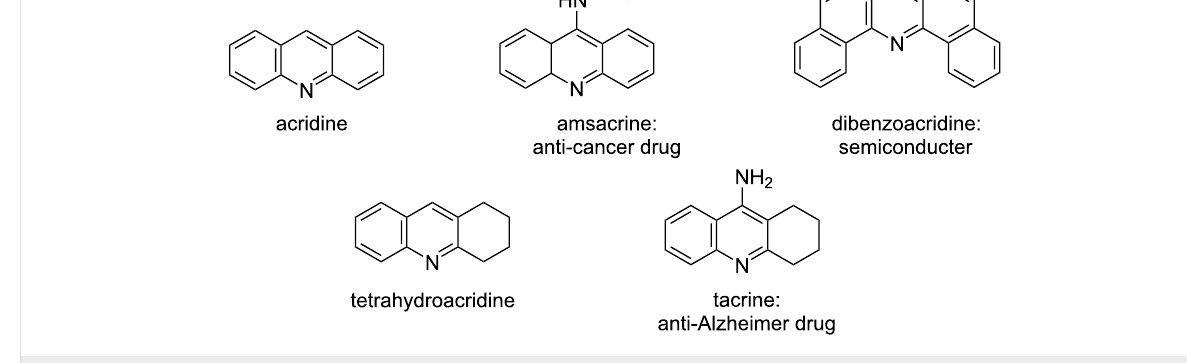
Figure 1: Applications of acridines.